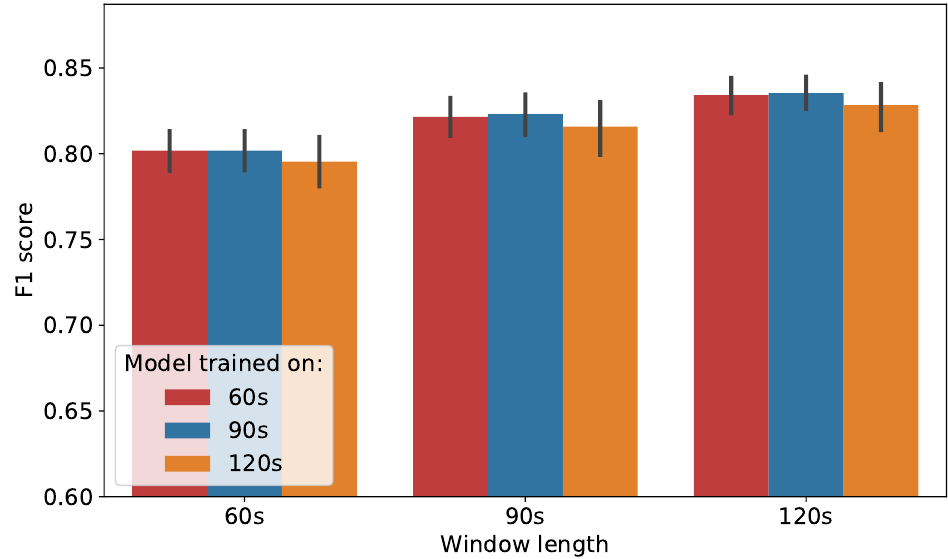
Figure 8. Performance of models trained and evaluated on different window